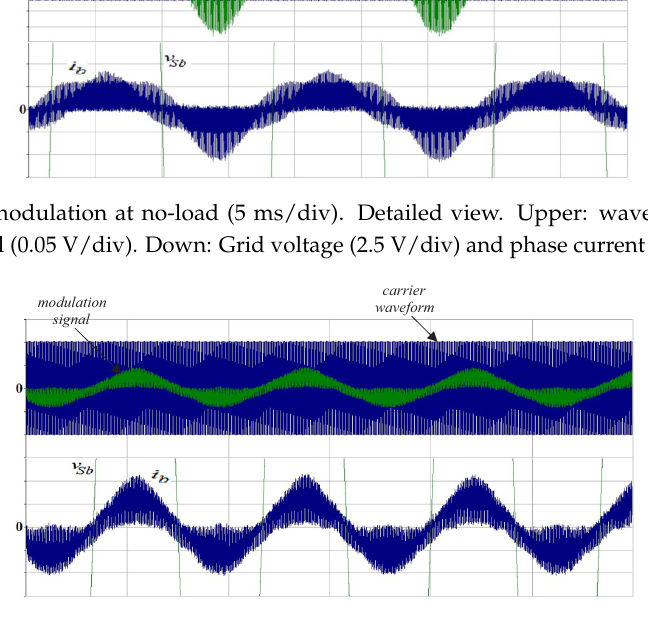
Figure 14. No overmodulation (5 ms/div). Detailed view. Upper: waveform carrier and modulation signal (0.05 V/div). Down: Grid voltage (2.5 V/div) and phase current (2.5 A/div).